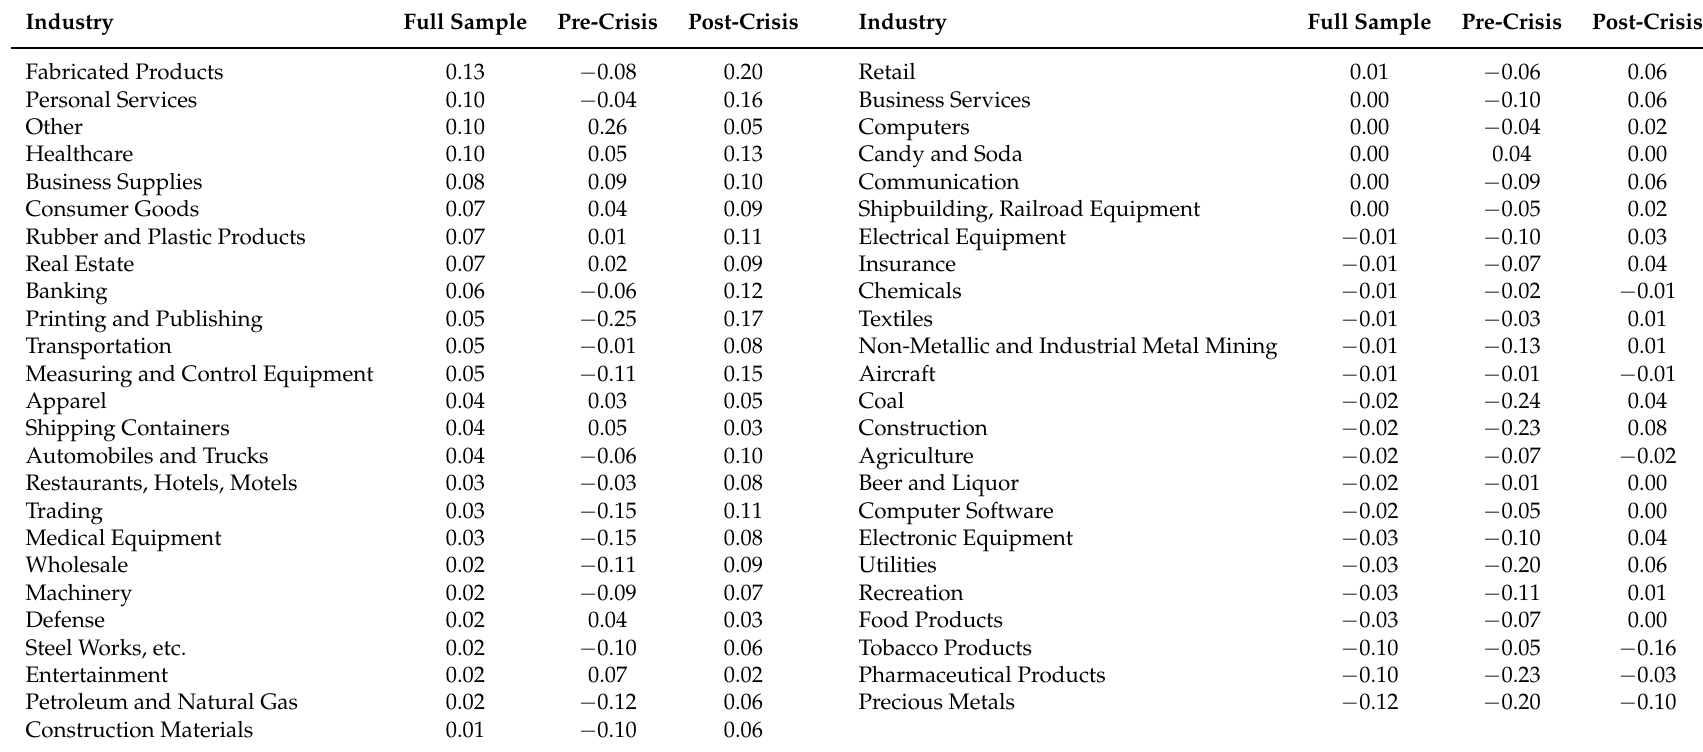
Table A5. The table reports the Pearson correlation between the contemporary art index and each of the Fama and French 49 industry groups over three time periods. Full sample refers to correlations computed using monthly data ranging from 2002:07 to 2017:09; pre-crisis correlations are computed using data ranging from 2002:07 to 2008:08; and post-crisis correlations are computed using data ranging from 2008:09 to